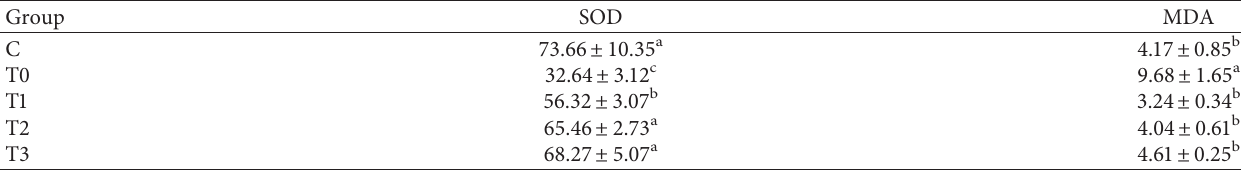
Table 1: SOD activity (%) and MDA level (nm/mL) of rats exposed to TCDD and treated with α -tocopherol. Group